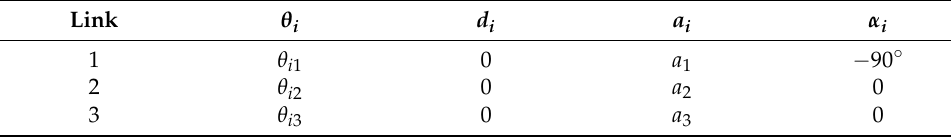
Figure 3. D–H coordinate frames of HexWalker II. Table 1. D–H parameters for the HexWalker II’s leg.